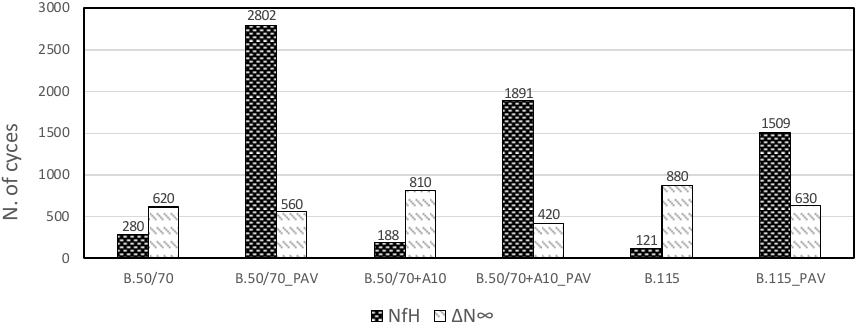
Figure 8. Model parameters for all investigated binders in iso-thermal condition.